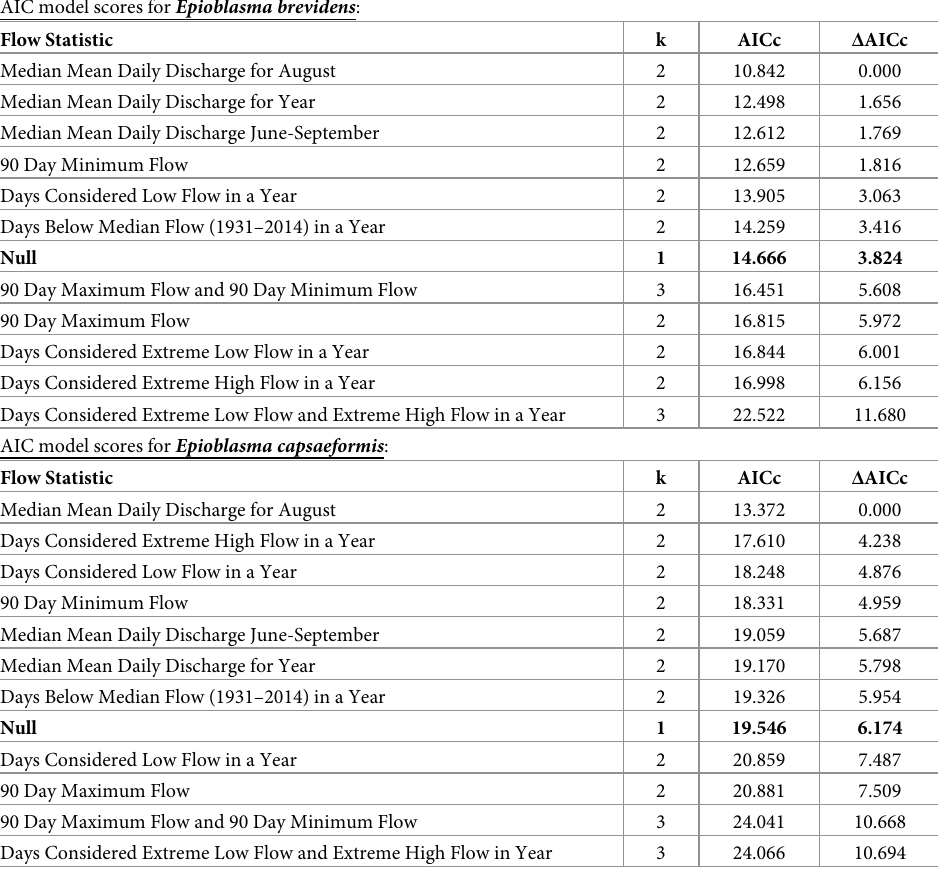
Table 6. Linear models explaining realized per-capita growth rate for Epioblasma brevidens and E . capsaeformis using flow statistics were compared by Akaike Information Criteria (AICc). Growth rate was calculated using juve- niles and adults. Δ AICc > 2 is generally accepted to be a model with greater relative support. Small sample sizes limited the range of responses. k = number of parameters in a model. AIC model scores for Epioblasma brevidens